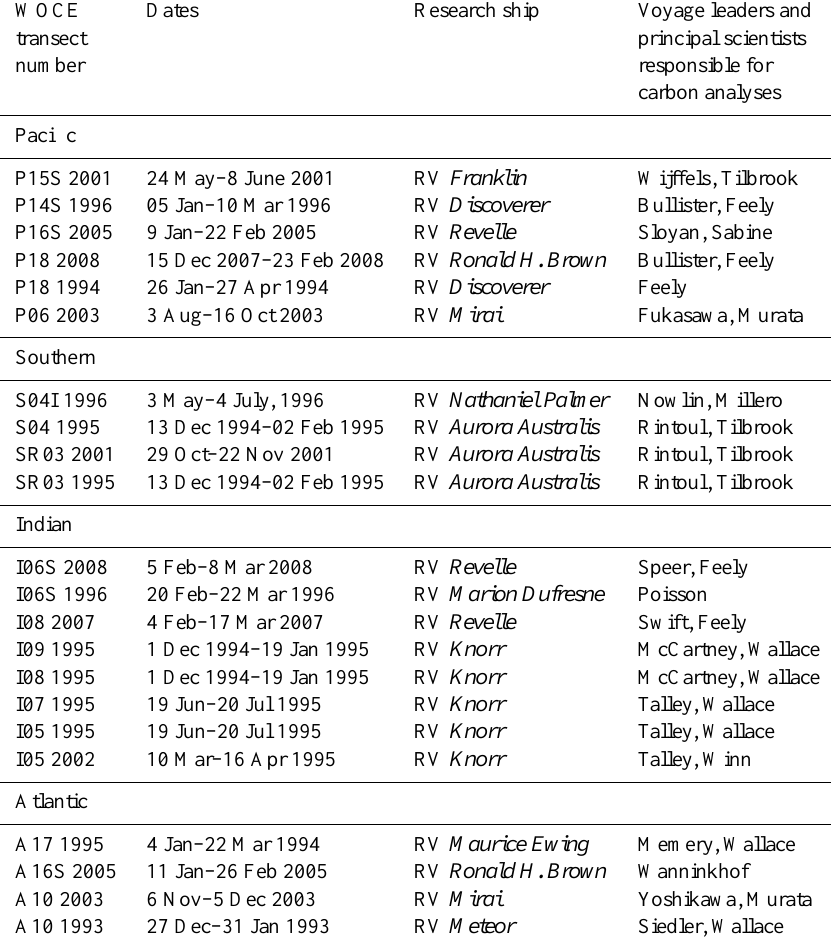
Table 1. GLODAP/CLIVAR voyages used for this study.